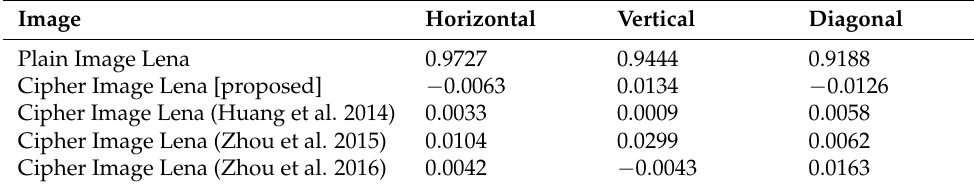
Table 3. Correlation coefficients between adjacent pixels of plain images and cypher